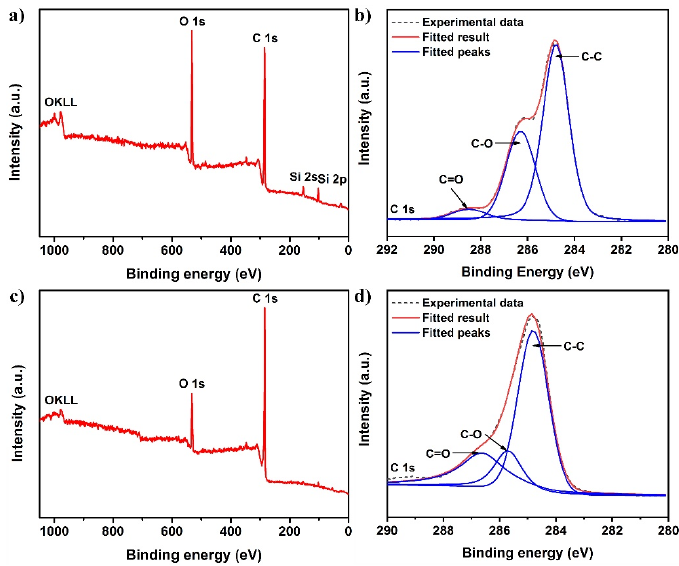
Figure 4. ( a ) XPS survey spectrum and ( b ) high-resolution C 1s spectra of glued SSM. ( c ) XPS survey spectrum and ( d ) high-resolution C 1s spectra of CS-coated mesh.